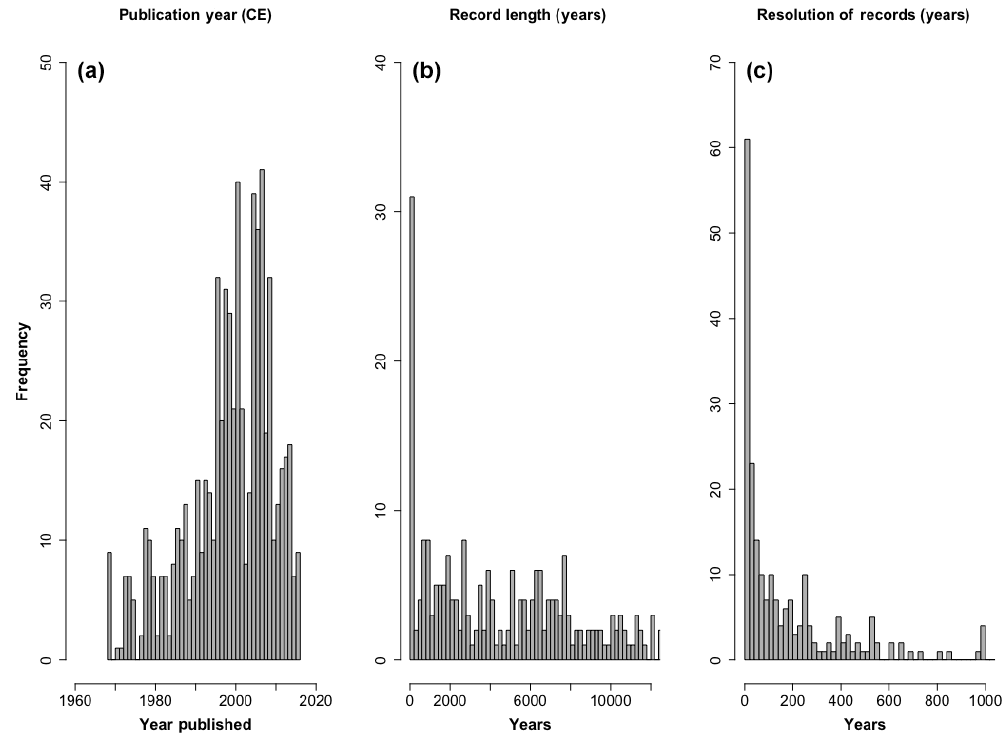
Figure 2. Metadata for all Australasian records. Data are presented for (a) publication year for most recent presentation of each record, (b) length of time between the oldest and youngest samples (where possible to calculate), and (c) sampling resolution (years sample − 1 ) of the record (where possible to calculate for lake/wetland, speleothem, and marine